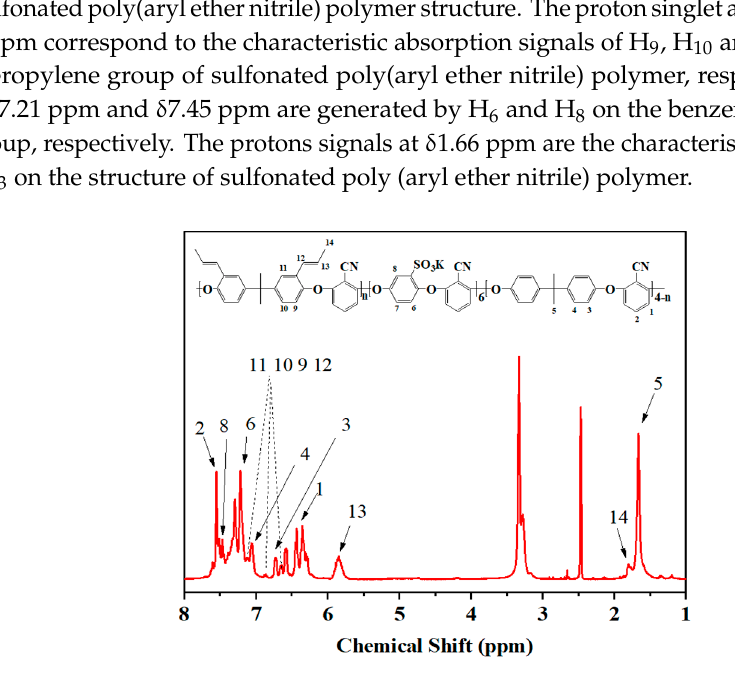
Figure 1. Nuclear magnetic resonance (NMR) spectrogram of SPEN-60-DBA-40.